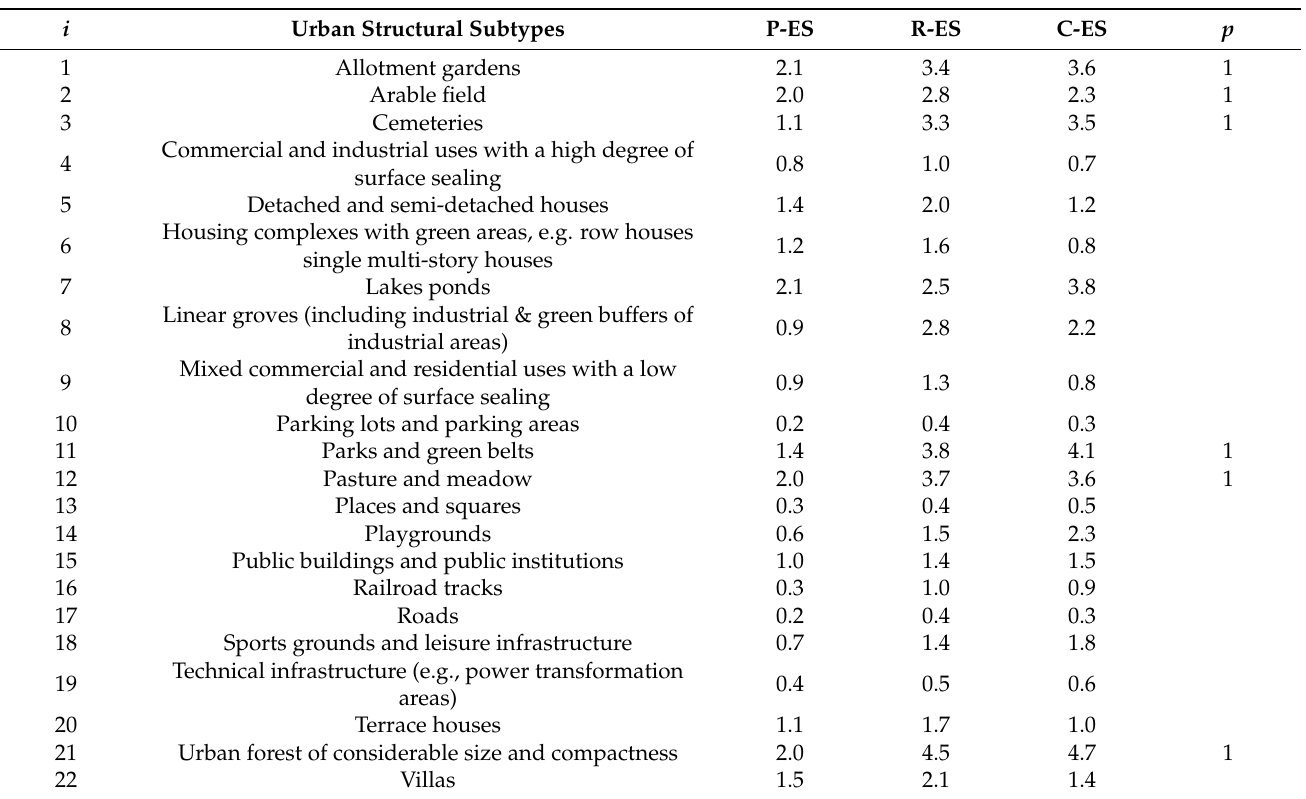
Table 1. List of USSs and ES values used in the assessment. P-ES: provisioning ES; R-ES: regulating ES; C-ES: cultural ES. Column p indicates USSs that are terrestrial open space on natural soils. Values for P-ES, R-ES and C-ES are the mean of the single ES in each of the P-ES, R-ES and C-ES groups. The range is 0 to 5. High values indicate high ES supply provided by the